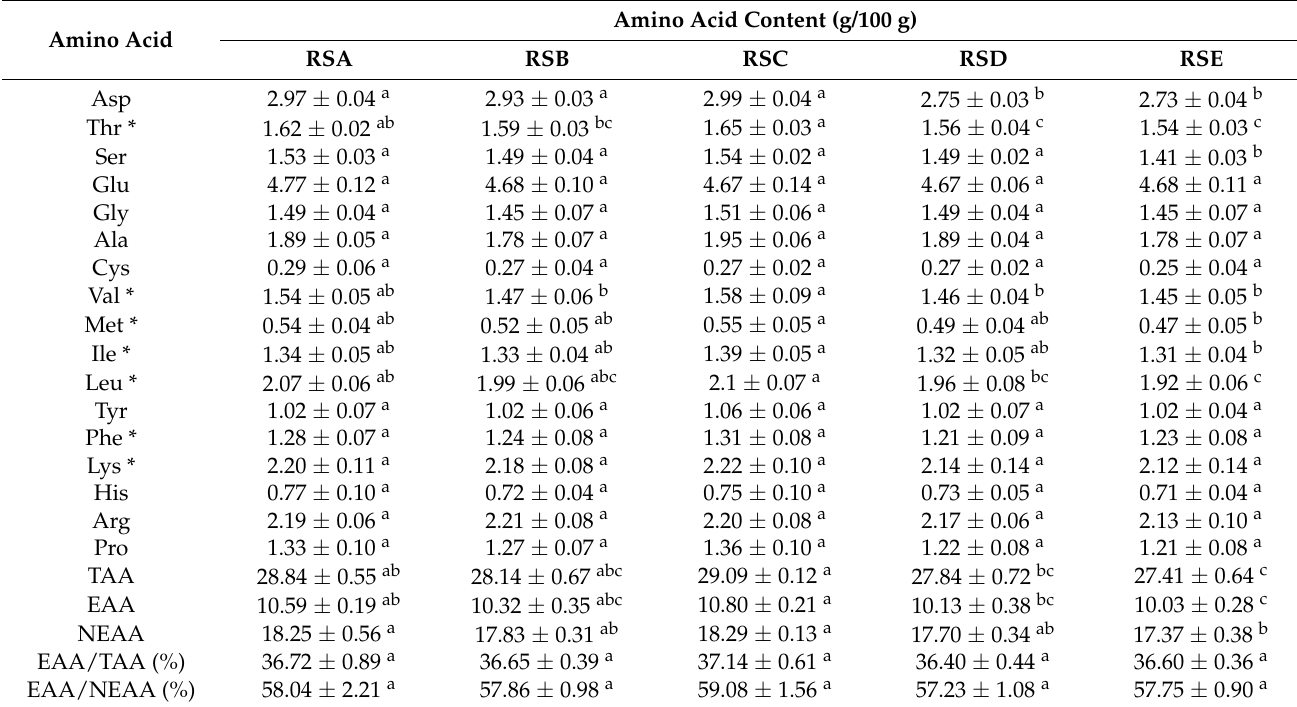
Table 3. Amino acid composition of M. importuna under different rotation systems.